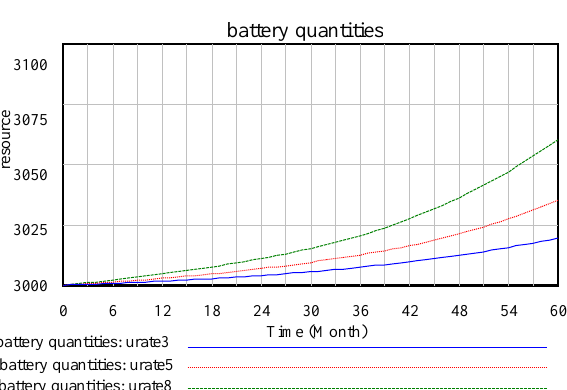
Figure 11. Demand. Figure 11. Demand.